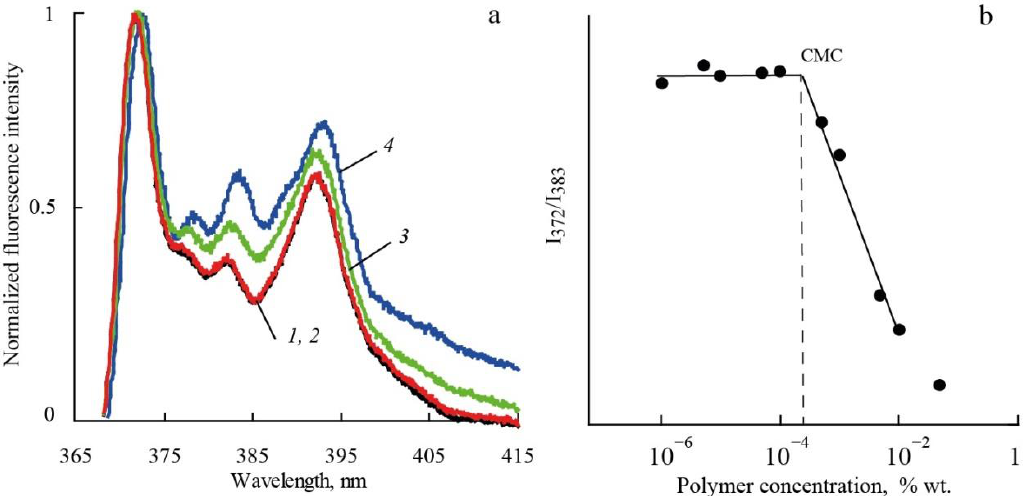
Figure 2. ( a ) Normalized fluorescence spectra of pEPM at concentrations, % wt.: 0.00001 ( 1 ), 0.0007 ( 2 ), 0.05 ( 3 ), 0.1 ( 4 ); ( b ) I 1 /I 3 ratio of the vibronic band intensities of pyrene as a function of pEPM concentration at 25 °C.